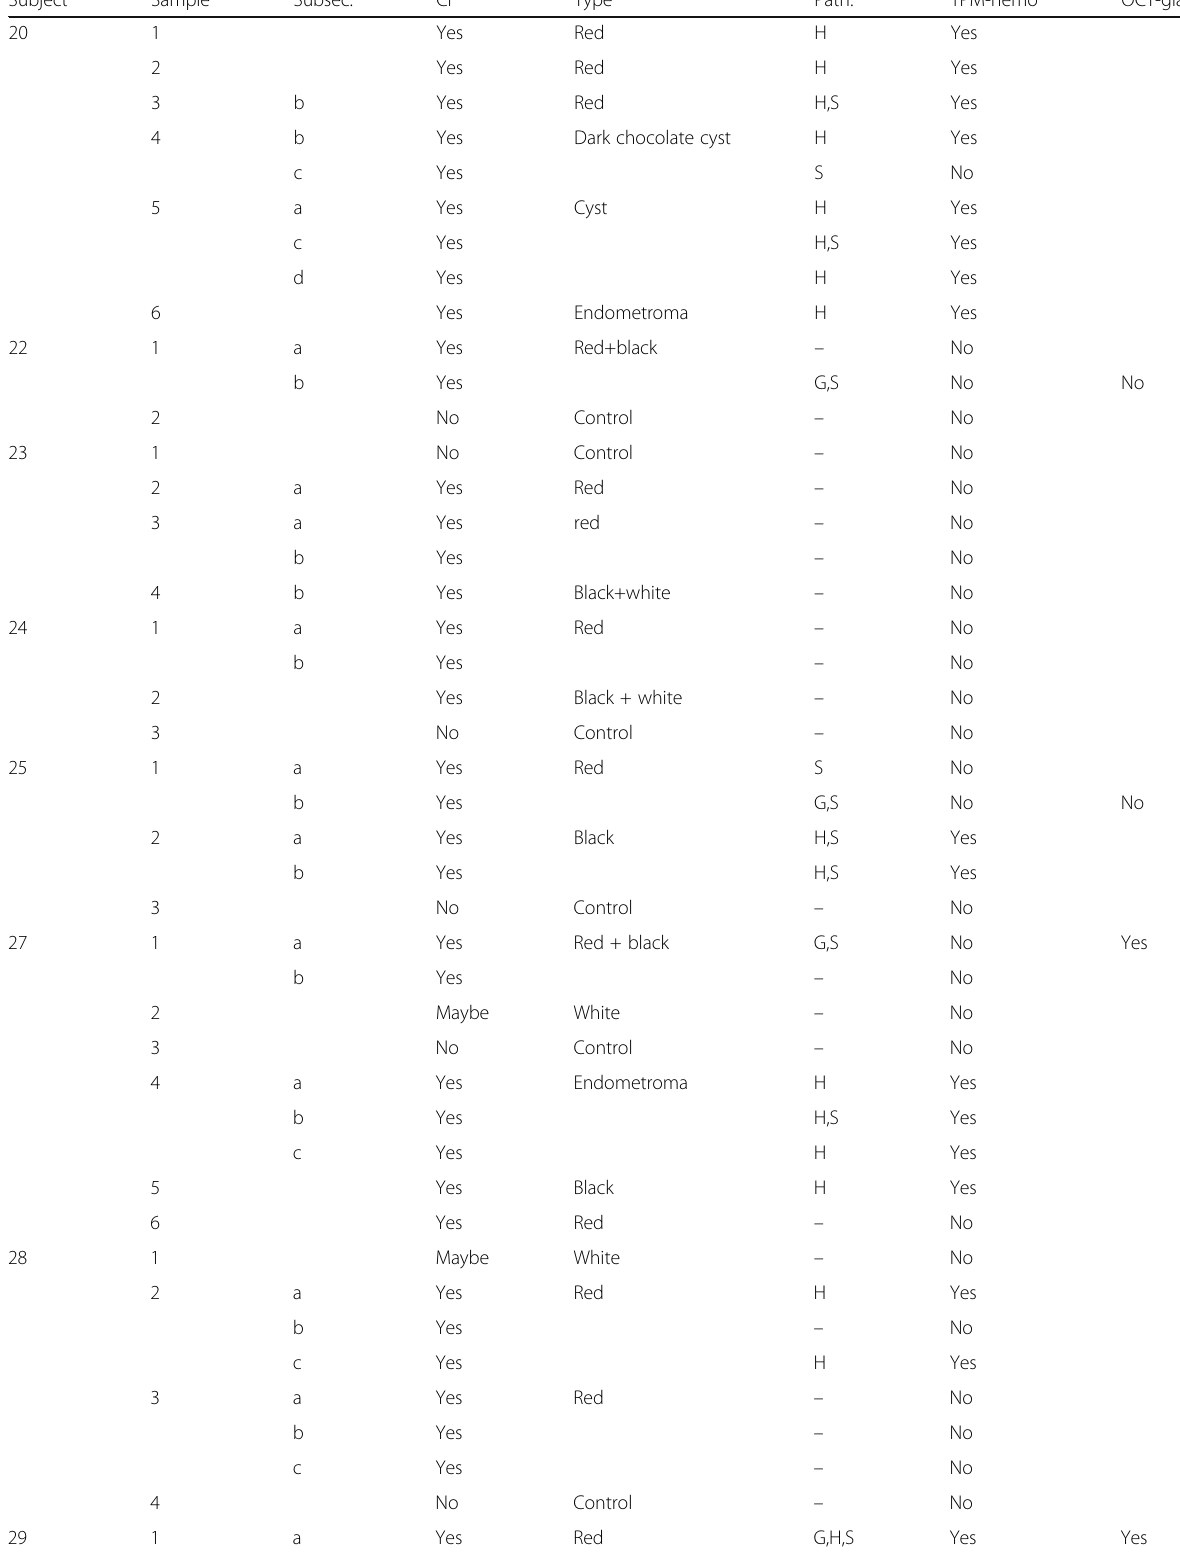
Table 3 Full Imaging